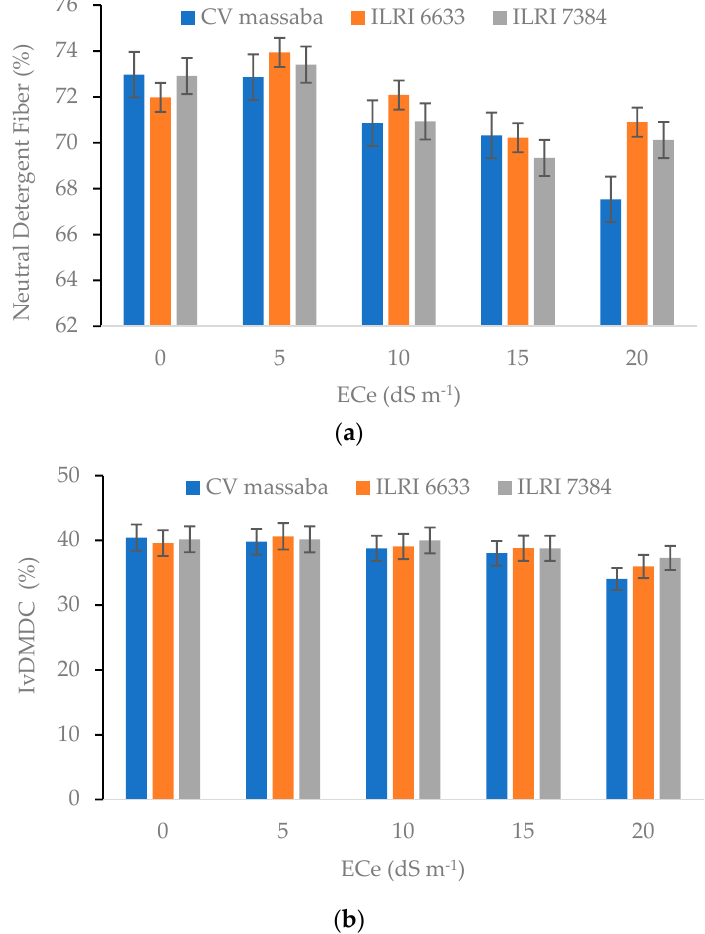
Figure 6. Effect of different salinity levels on ( a ) Neutral Detergent Fiber (NDF) (LSD = 2.72; CV = 21.85) and ( b ) Invitro dry matter digestibility content (IvDMDC) (LSD = 3.19; CV = 20.83) on three Chloris gayana genotypes.